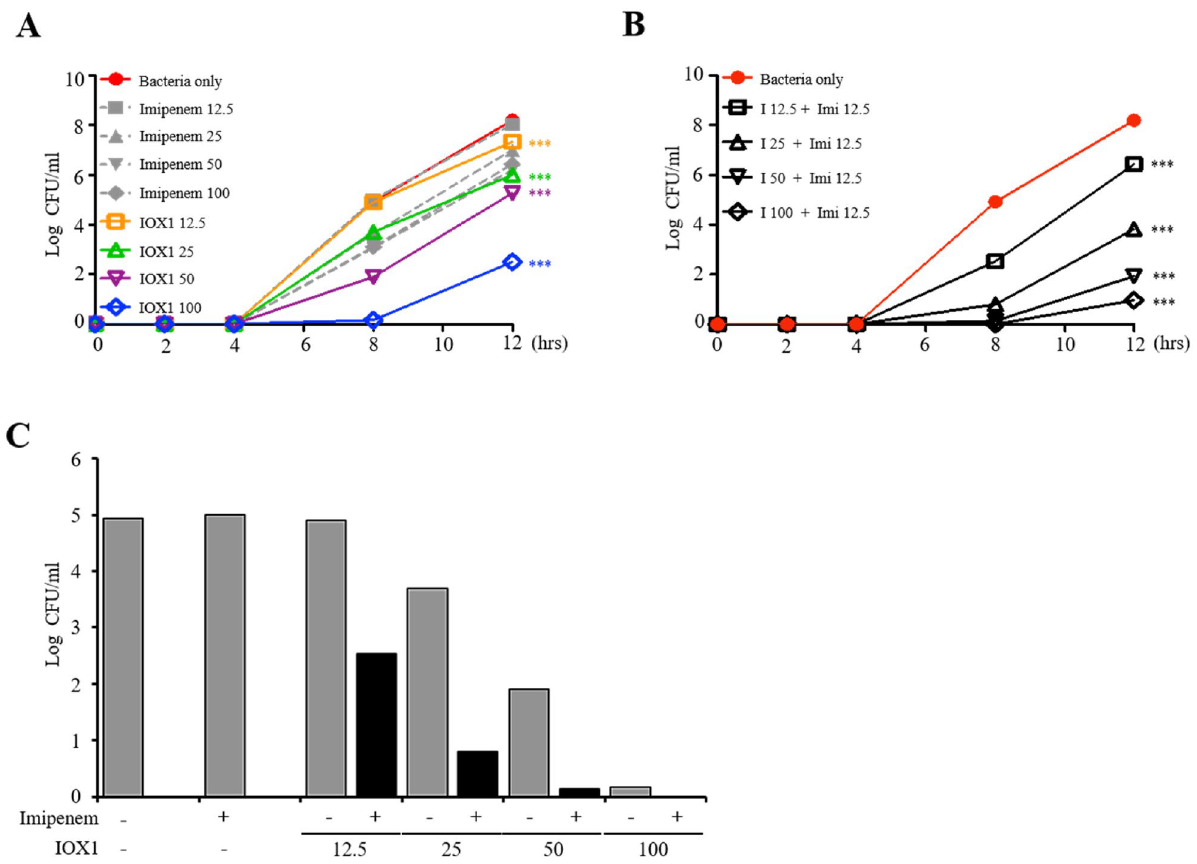
Figure 7. IOX1 enhances the killing of carbapenem-resistant A. baumannii . ( A ) Bactericidal kinetics of imipenem against resistant and susceptible CRAB 90 (4.66 × 10 4 CFU/ml) compared to those of IOX1. ( B ) Synergistic antibacterial effect of a low concentration combination of IOX1 and imipenem on CRAB 90 (4.66 × 10 4 CFU/ml). ( C ) The effect of IOX1 on bacterial growth in the presence or absence of imipenem at 8 h of